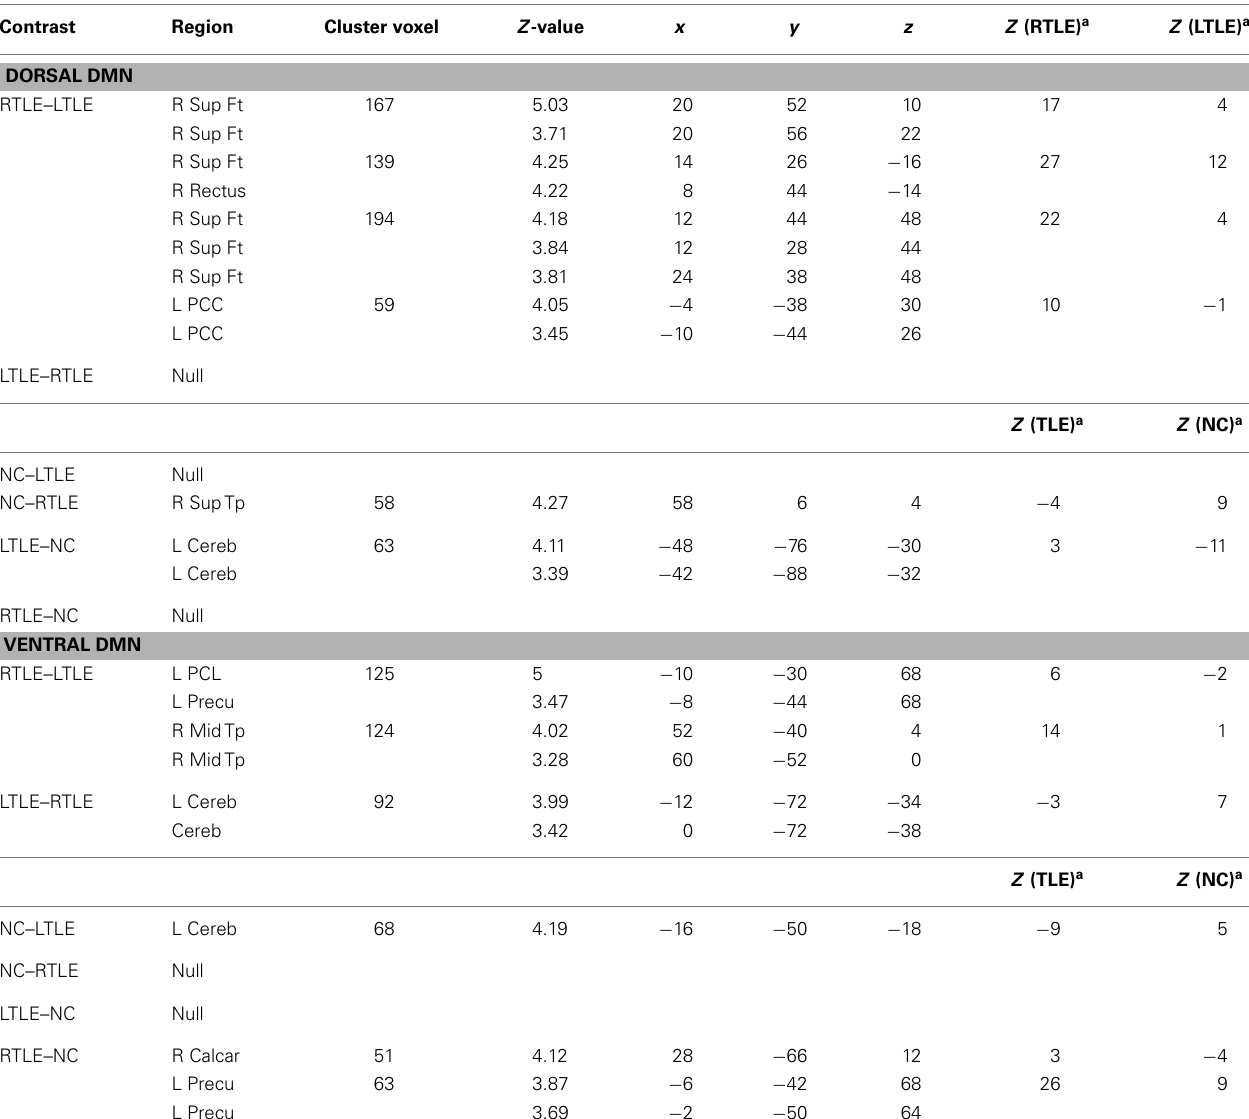
Table 2 | Description of the significant differences within each DMN subdivision, between the experimental groups, pre-surgery